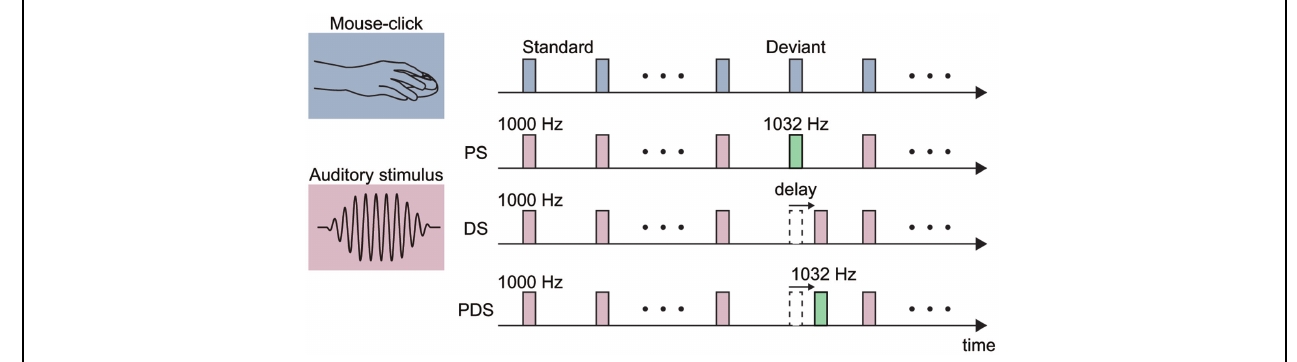
FIGURE 1 | Schematic illustration of the experimental stimuli. Each stimulus was either elicited by a mouse-click performed by the participant (action condition; top) or presented passively with a fixed (1 s) interval (non-action condition in Experiments 1 and 2). A pitch-deviant stimulus (PS) was used in Experiments 1 and 3. The PS was a 1032-Hz pure tone (presentation rate 20%) and the standard stimulus was a 1000-Hz pure tone (80%). Delayed stimuli (DS) were used in Experiments 2–4. The delay length was fixed at 150 ms in Experiments 2 and 3, and varied from 100 to 400 ms in Experiment 4. A pitch-deviant delayed stimulus (PDS) was used in Experiment 3. Specifically, this was a 1032-Hz pure tone presented with a 150 ms delay with respect to the